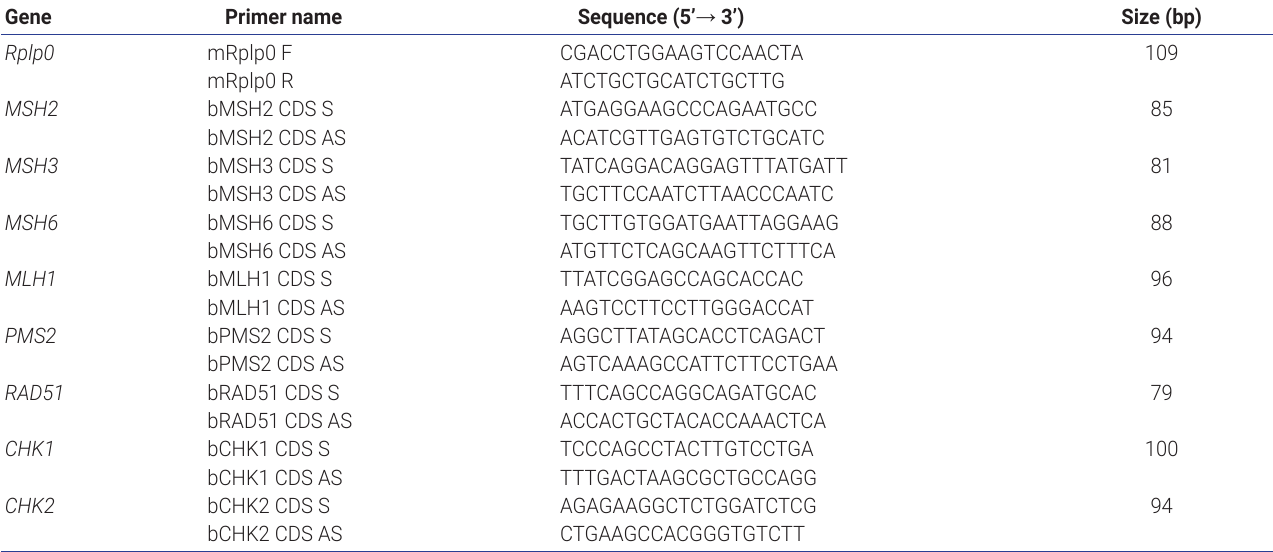
Table 1. Primers used for quantitative real-time polymerase chain reaction analysis of specific genes